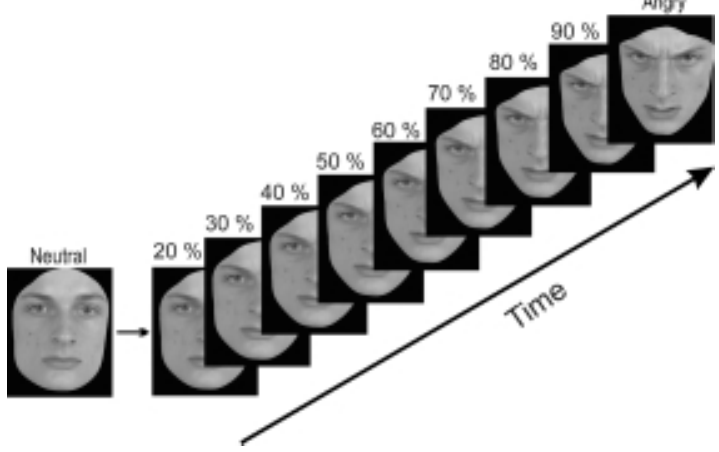
Fig. 1. The Emotional Recognition Task. Picture shows the nine end points of emotional intensity for the angry face. In the actual test, video clips were shown morphing from neutral to one of these end points for all emotion